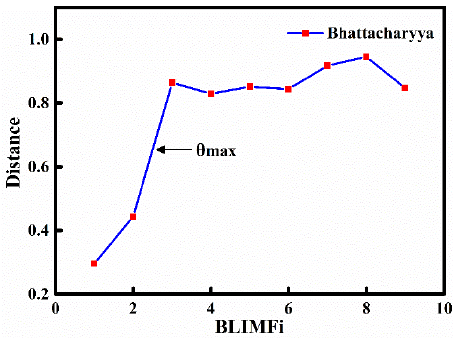
Figure 5. Bhattacharyya distance between modes and the Bumps signal. BLIMF is band-limited intrinsic mode function.